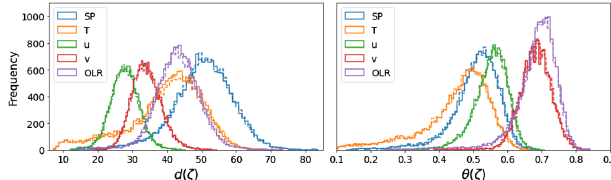
FIG. 10. Histograms of local dimension d ð ζ Þ and inverse of persistence θ ð ζ Þ for the multivariate representation (referred to as state space “ SP ” ) and univariate fields (i.e., T, u, v, and OLR) in ERA5. Dashed lines: univariate and SP representations living in N ¼ 25 239 and N ¼ 100 956 , respectively. Solid lines: univari- ate and SP representations living in N ¼ 4273 and N ¼ 17 092 , respectively.